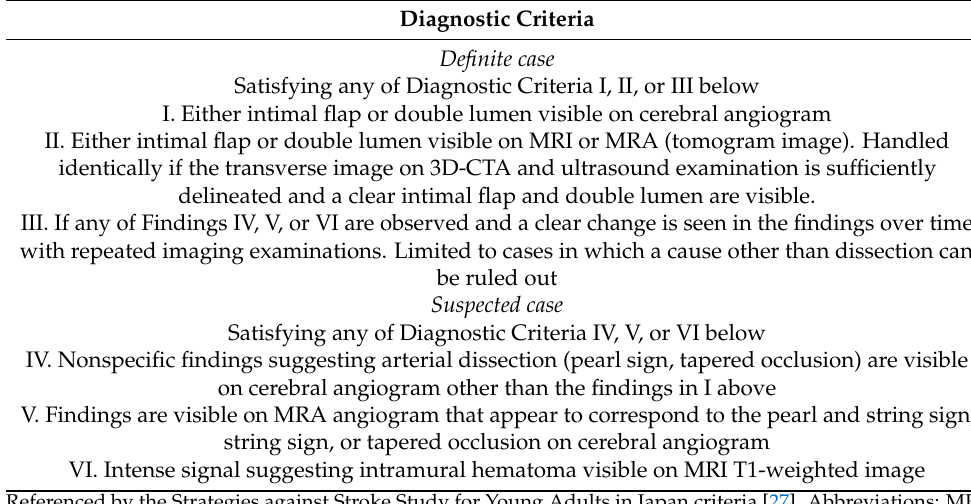
Table 1. Diagnostic criteria for intracranial artery